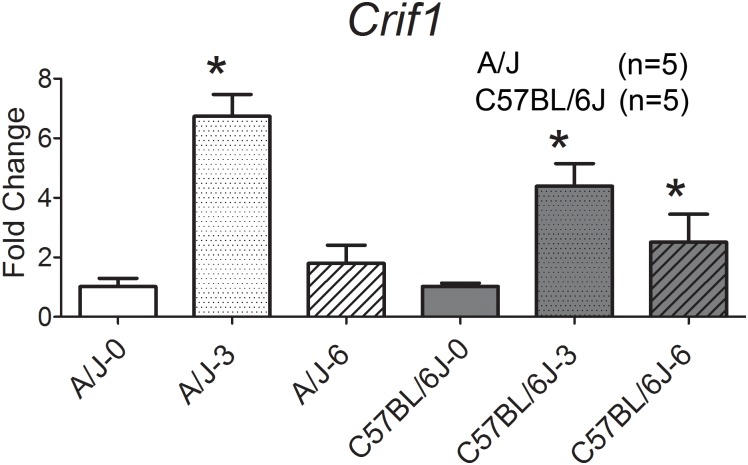
Crif1 expression is upregulated in S. aureus-infected A/J and C57BL/6J mice by qPCR.Consistent expression pattern of Crif1in A/J and C57BL/6J mouse (n = 5 in each group). Crif1 showed consistent uninfected vs infected expression patterns between mouse and humans (Figs 4 and 5) At 3 hours and 6 hours post S. aureus challenge, Crif1 is upregulated 6.7 fold (p<0.05) and 1.8 fold (p = 0.4) respectively in A/J, and 4.4 fold (p<0.05) and 2.5 fold (p = 0.14) in C57BL/6J. The normalization was conducted within each strain for comparing different time points (e.g. C57BL/6J time points were normalized to C57BL/6J pre-infection time point and A/J time points were normalized to A/J pre-infection time point.) All mice were 8-week old males.